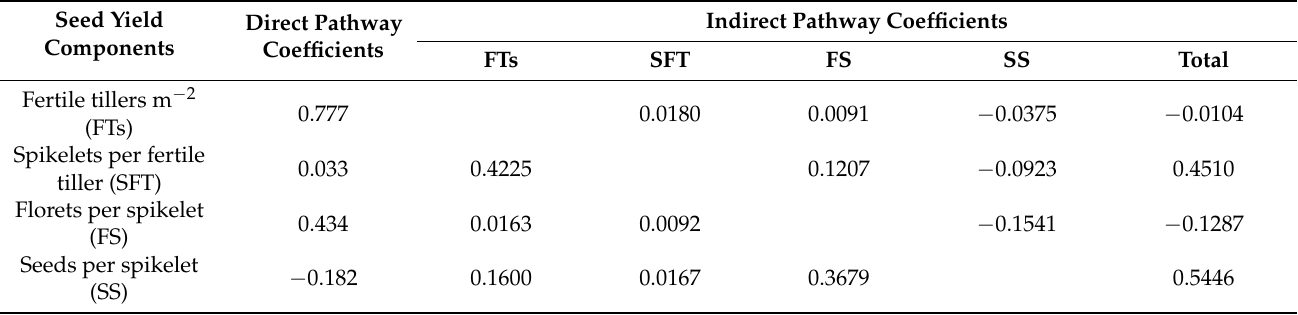
Table 6. Pathway analysis for direct and indirect effects of seed yield components on seed yield in smooth